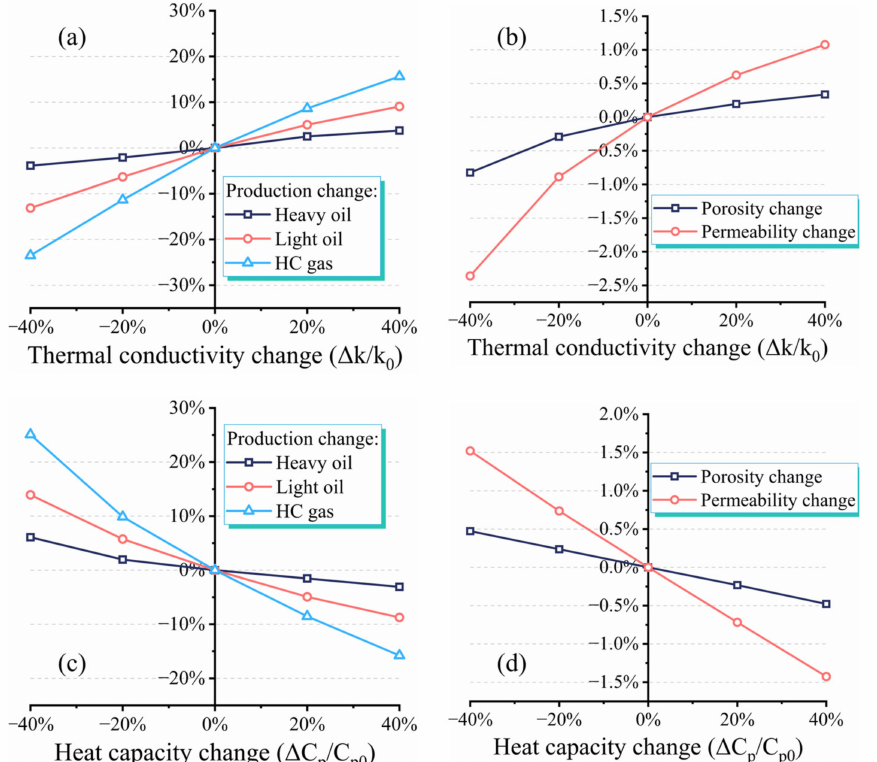
Figure 9. Sensitivity analysis of thermal conductivity on ( a ) cumulative production of fluid compo- nents. ( b ) average porosity and permeability. Sensitivity analysis of heat capacity on ( c ) cumulative production of fluid components. ( d ) average porosity and